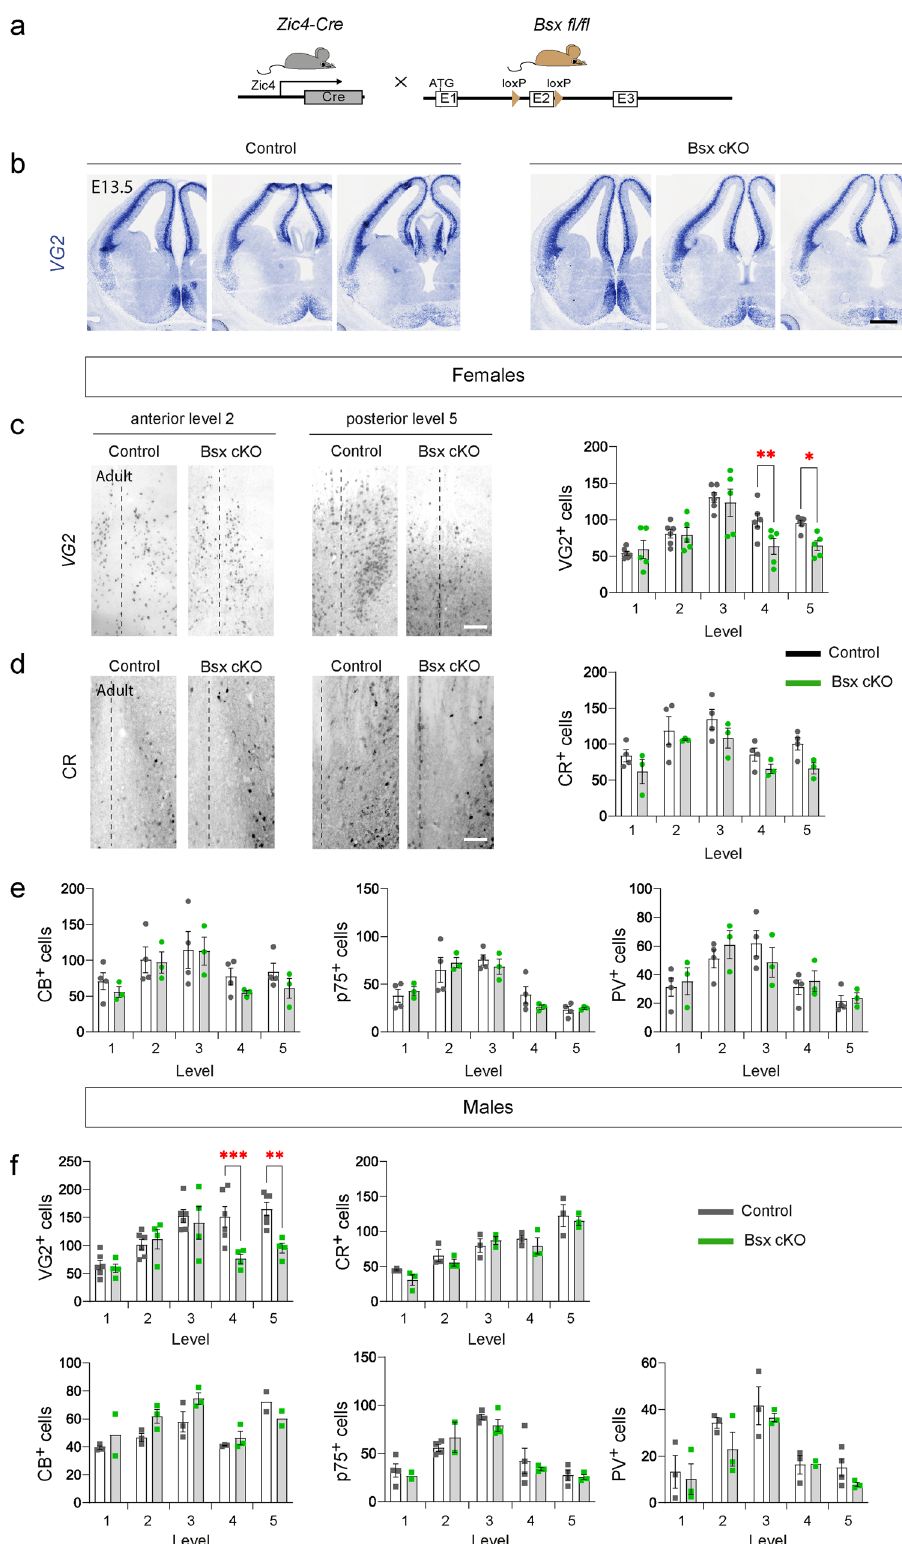
fi ndings, together with the prominent role of glutamatergic MS neurons in voluntary movement and locomotion 24,62 , allow us to propose that septal loss of BSX in glutamatergic neurons is suf fi cient to mediate locomotion de fi cits. Given the known interaction of the hypothalamus with the glutamatergic com- ponent of the MS 24,62,63 , hypothalamic loss of BSX may